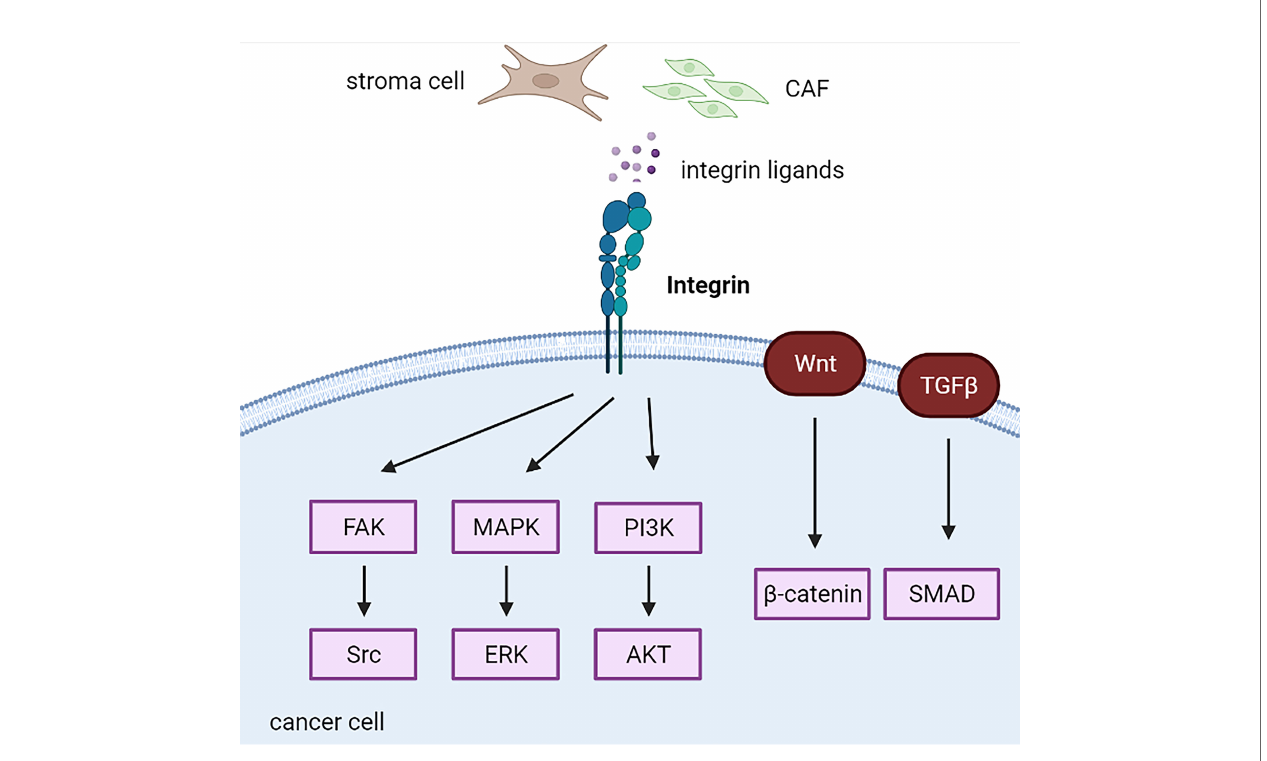
FIGURE 5 | Integrin-related cascades in cancer cells. CAF, cancer-associated fi broblast; CSC, cancer stem